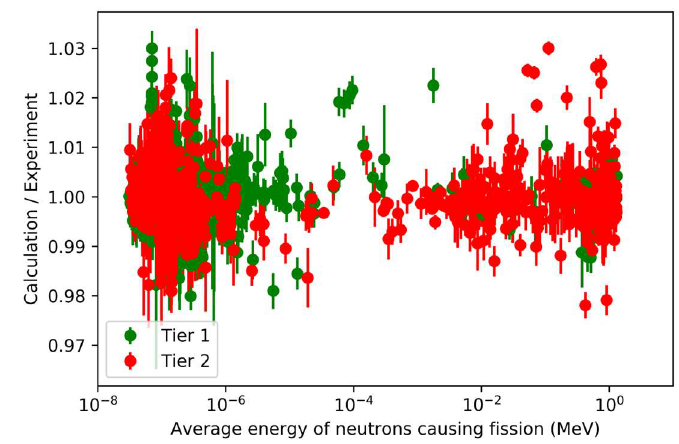
Figure 3. C/E Values for Tier 1 & 2 Validation